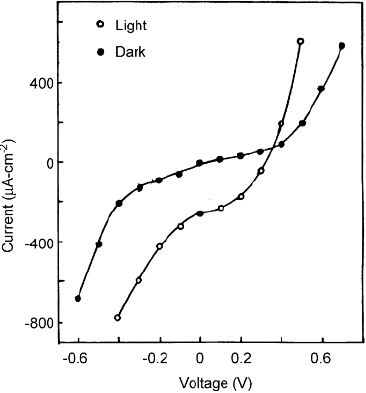
Figure 5. I-V characteristics for n-Bi 2 Se 3 /polysulfide PEC cell in dark and under illumination repro- duced with permission from [98], Elsevier,